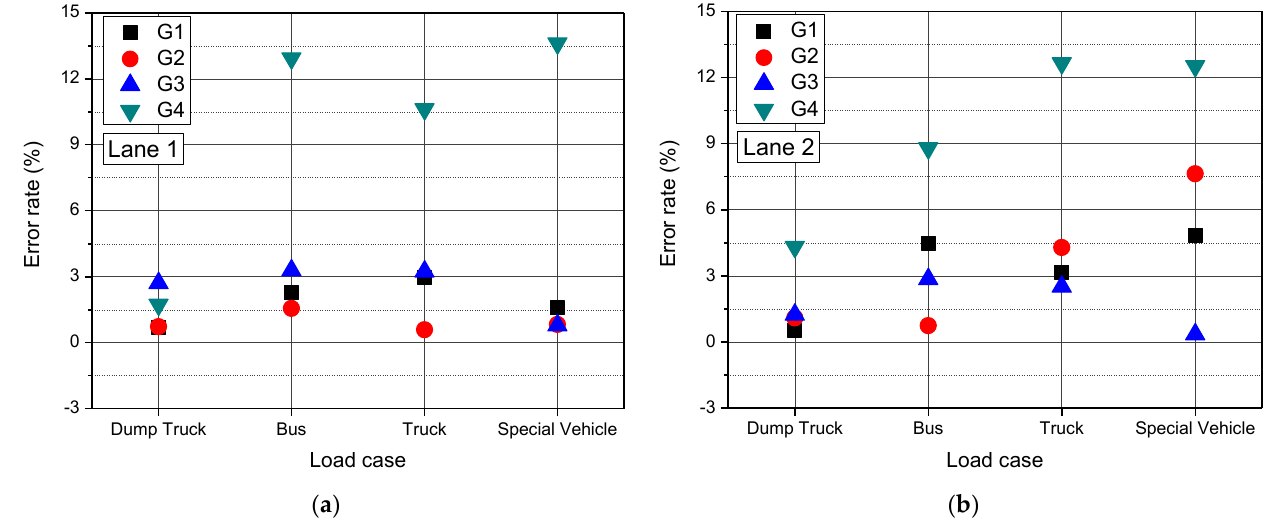
Figure 13. Error rate of LLDF according to the vehicle type and lane: ( a ) Lane 1; ( b ) Lane 2.